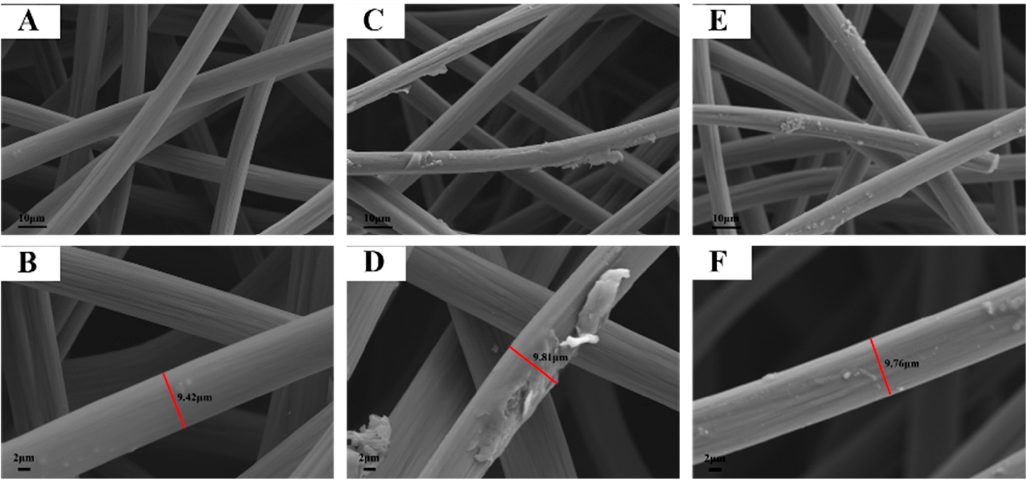
Figure 2. SEM images of bare CF ( A , B ), BPA–MIP@CF ( C , D ) and MIP@CF ( E , F ). FTIR spectra of bare CF, Bisphenol A, BPA–MIP@CF and MIP@CF were studied and